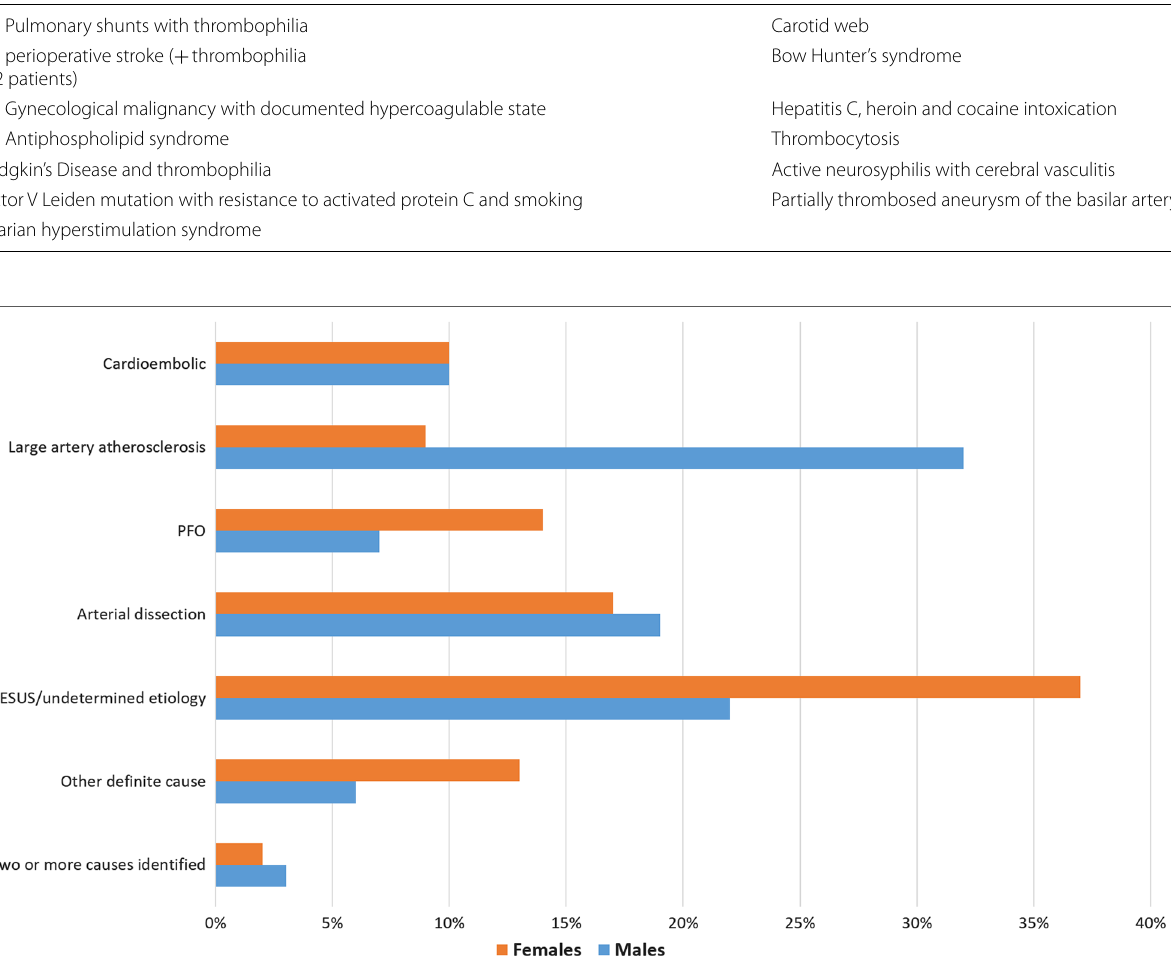
Table 2 Other determined stroke causes in young female and male acute ischemic stroke patients Young female ischemic stroke patients Young male ischemic stroke patients